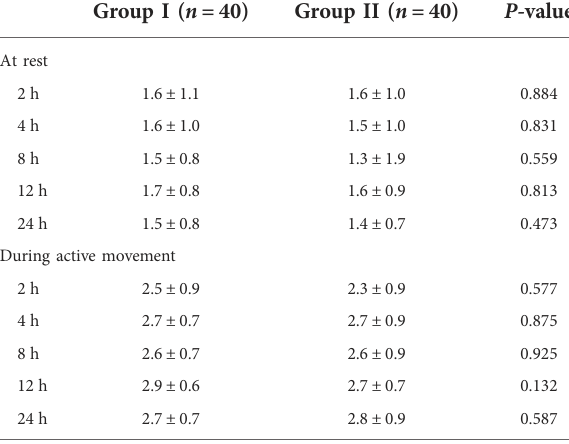
TABLE 5 Comparison of visual analog pain scores at postoperative timepoints.